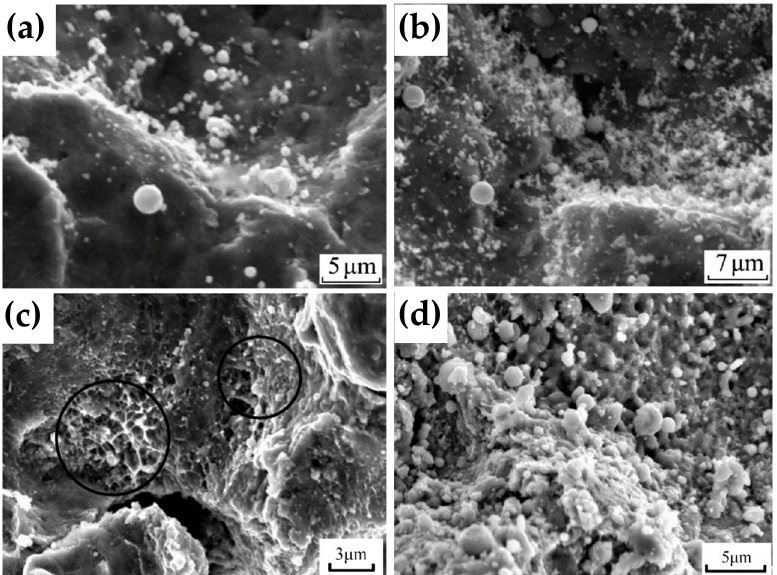
Figure 11. Surface morphology of cold-sprayed zinc coating (spraying gas N 2 ) under different spray- ing gas heating temperatures. ( a ) 165 °C, ( b ) 250 °C, ( c ) 410 °C, and ( d ) 450 °C [83].